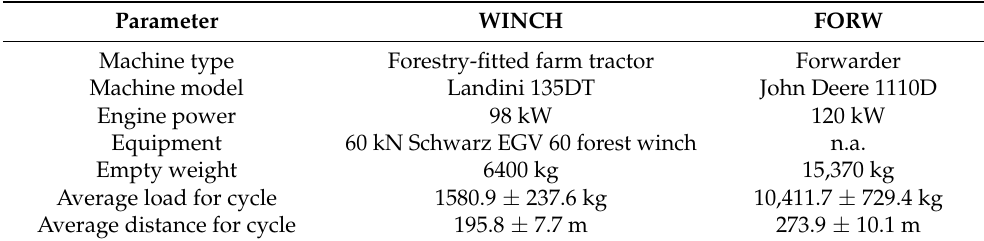
Table 1. Technical features of the applied machineries for WINCH and FORW experimental treat- ments and main average operative data (±SD).